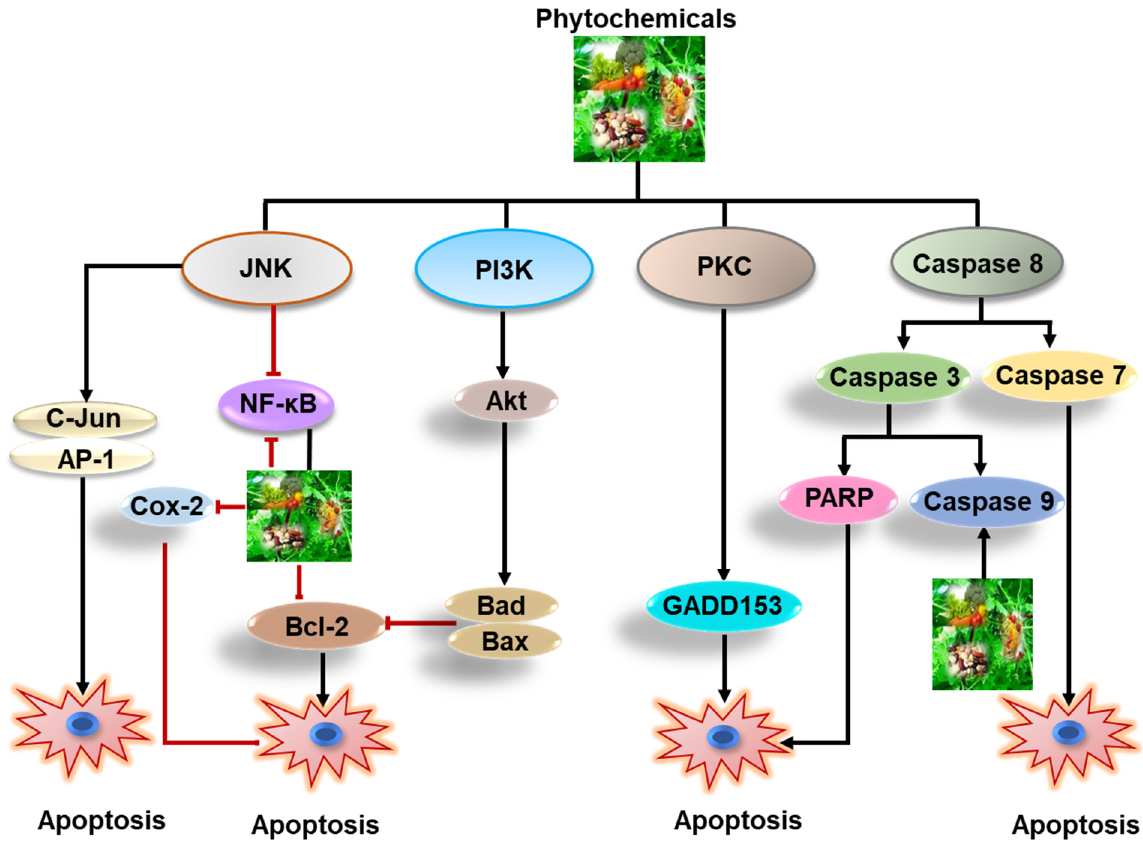
Figure 4. Depiction of important cellular pathways regulated by natural products that could be utilized for therapeutic purpose in solid